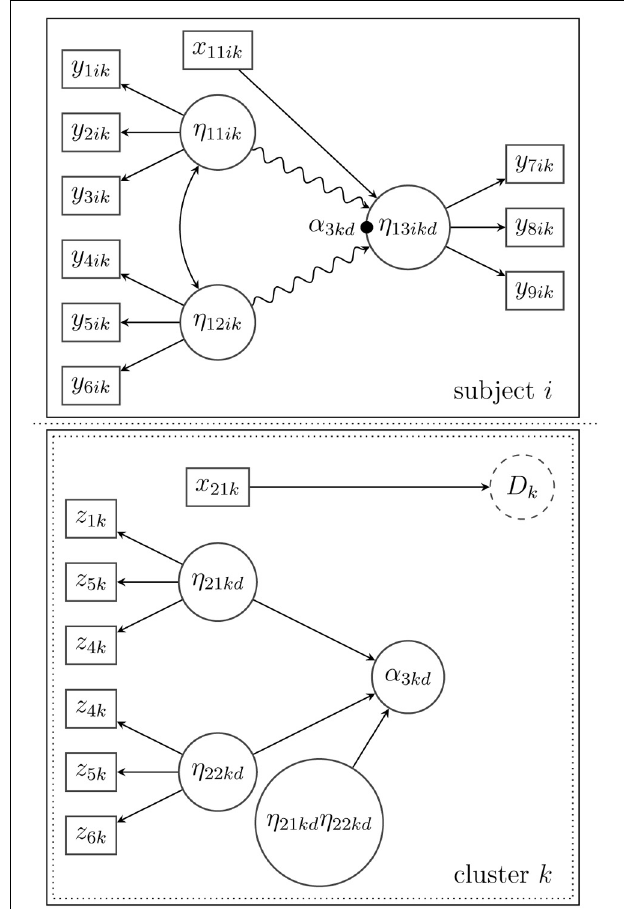
FIGURE 5 | Structural model for subject i in cluster k with a spline relationship between the latent variables on the within-level (indicated by the snake-type arrow), and a random intercept ( α 3 kd ) that is predicted by an interaction model on the between-level. The distribution of the between-level’s predictors is approximated by a mixture of normal distributions. The latent categorical variable D k is predicted by a between-level covariate x 21 k